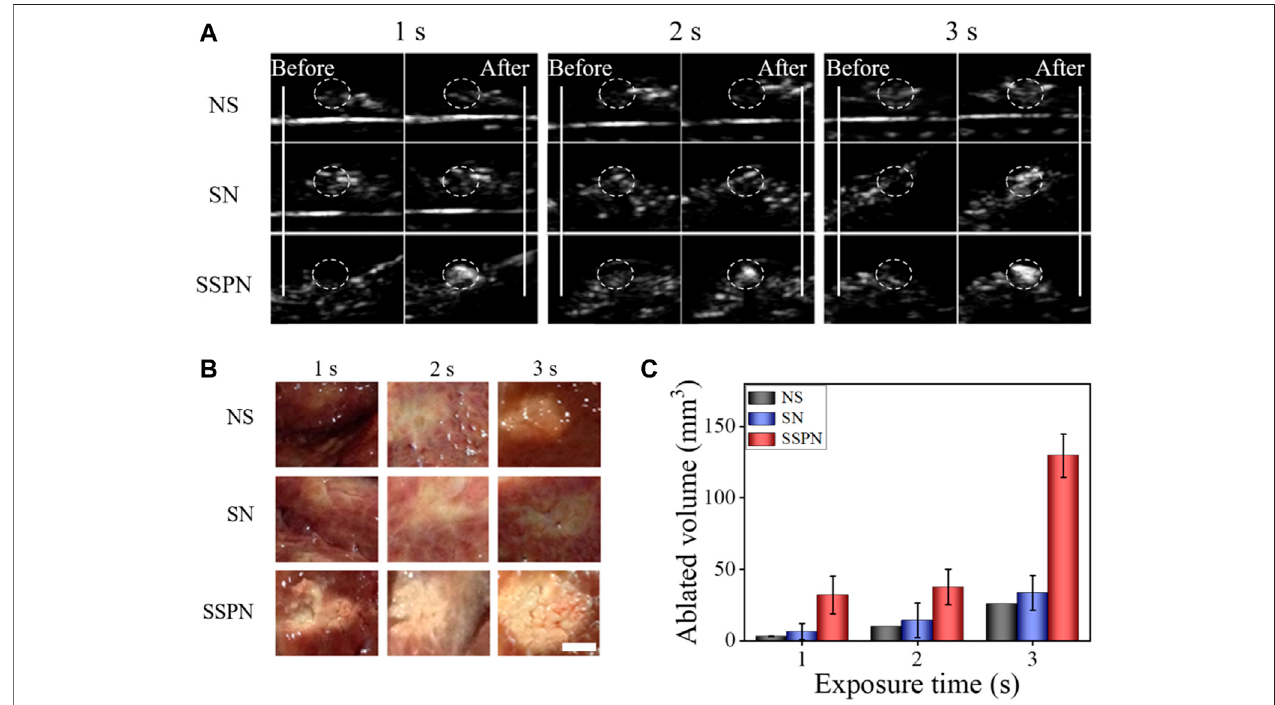
FIGURE 4 | (A) B-mode ultrasound images of NS, SN, and SSPN before and after HIFU irradiation on pig livers at 270 W for 1, 2, and 3 s. (B) Digital photos of ablated degassed pig livers at 270 W cm − 2 for 1, 2, and 3 s (scale bar = 5 mm). (C) The corresponding necrotic volumes after HIFU irradiation ( n = 3).